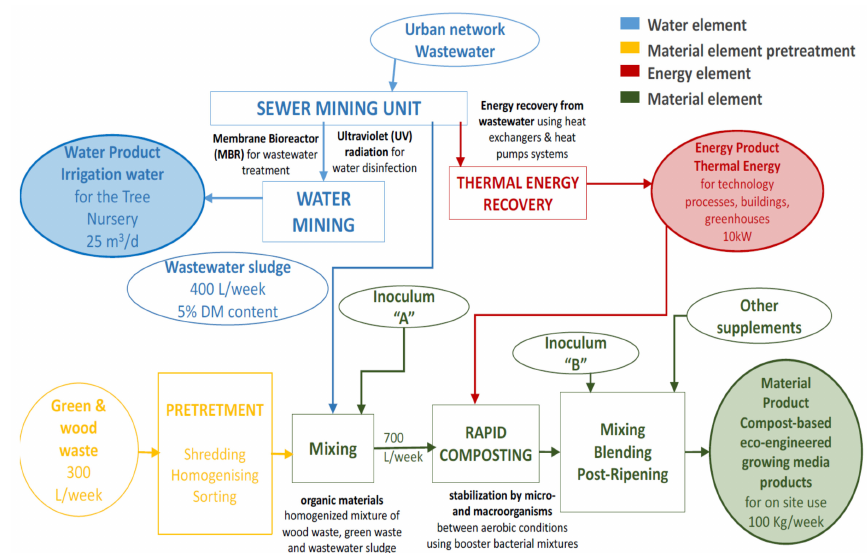
Figure 3. Circular economy approach for the Nursery in terms of water, energy and